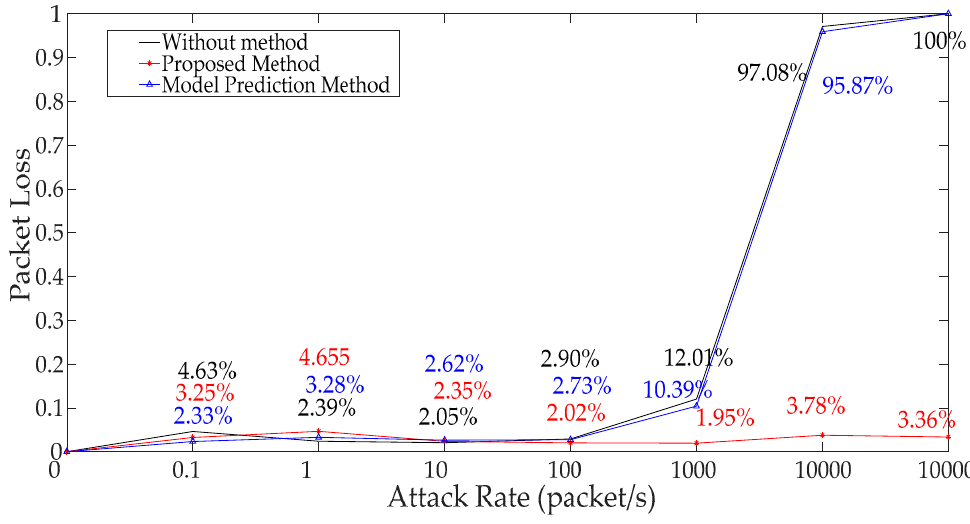
Figure 21. Different packet losses using different methods.